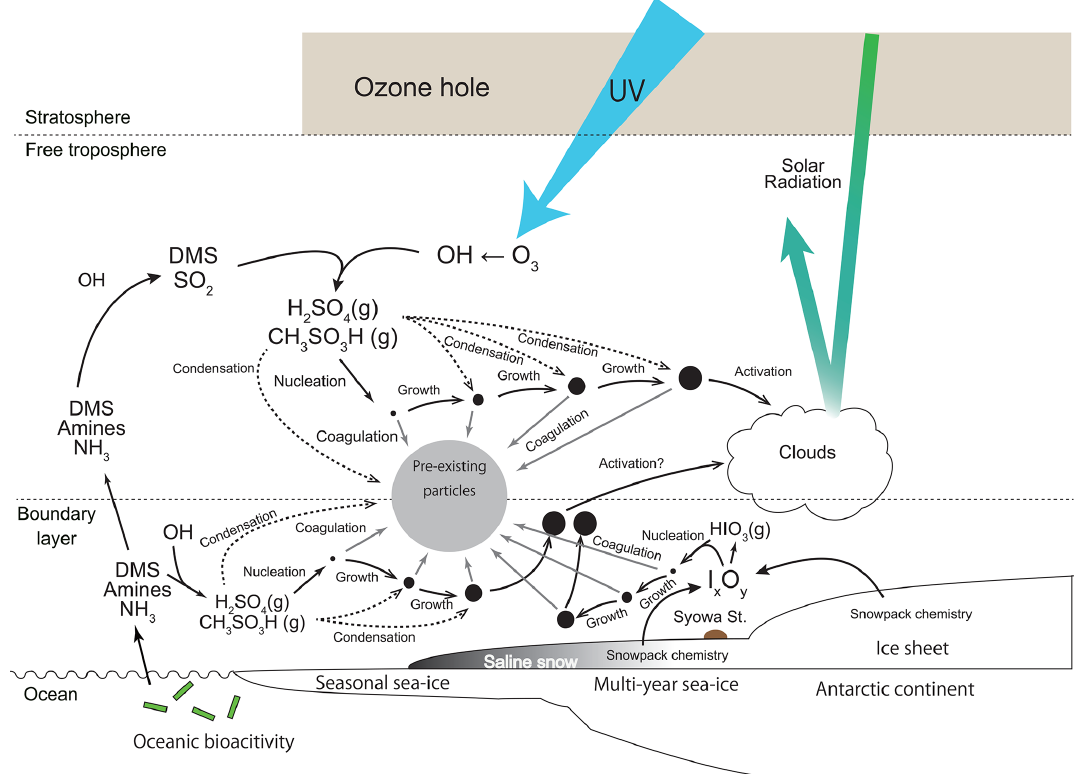
Figure 12. Schematic figure presenting our